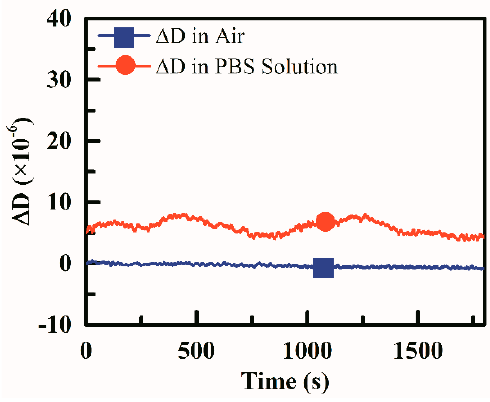
Figure 6. Dissipation stability performance of the platform.